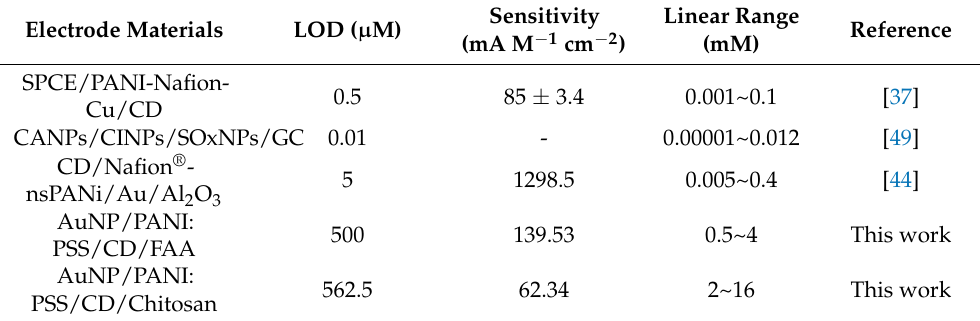
Table 3. Comparison of electrode properties for creatinine detection. Electrode